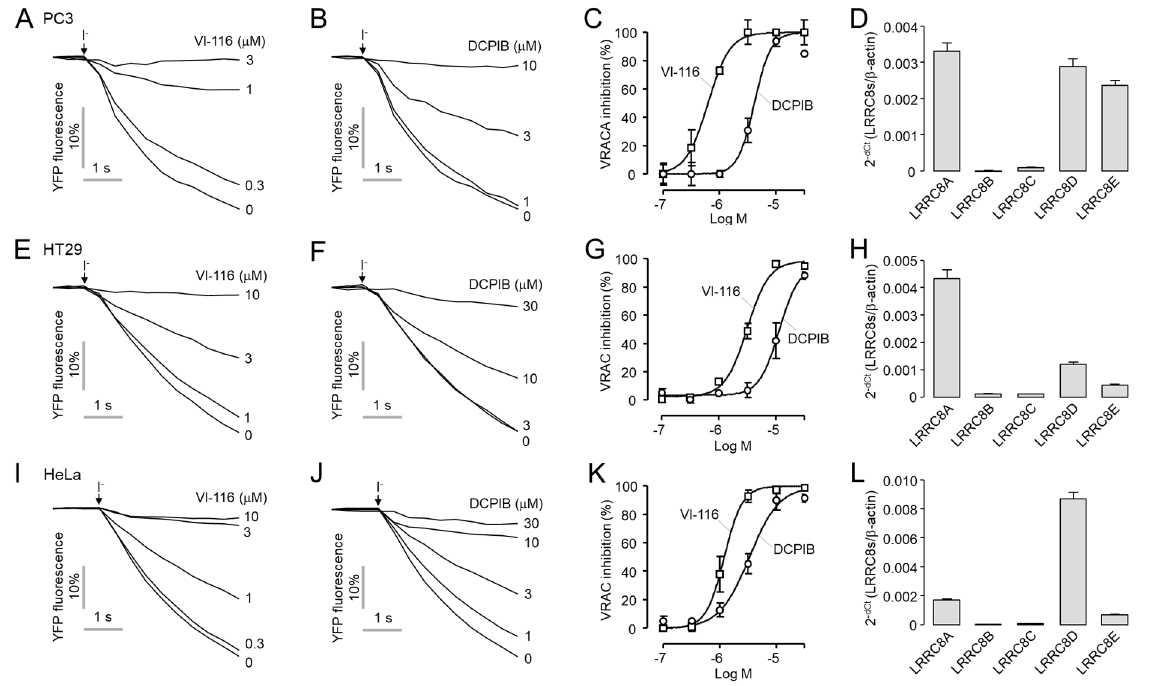
Figure 7. Effects of VI-116 and DCPIB on VRAC activity in PC3, HT29 and HeLa cells. ( A , B ) Repre- sentative YFP fluorescence traces for the inhibitory effects of VI-116 and DCPIB in PC3 cells. VRAC was activated by application of hypertonic solution for 5 min. ( C ) Summary of dose-response (mean ± S.E., n = 4). ( D ) LRRC8A − E mRNA expression levels in PC3 cells. ( E , F ) Inhibitory effects of VI-116 and DCPIB in HT29 cells. VRAC was activated by application of hypertonic solution for 5 min. ( G ) Summary of dose-response (mean ± S.E., n = 4). ( H ) LRRC8A − E mRNA expression levels in HT29 cells. ( I , J ) Inhibitory effects of VI-116 and DCPIB in HeLa cells. VRAC was activated by application of hypertonic solution for 5 min. ( K ) Summary of dose-response (mean ± S.E., n = 4). ( L ) LRRC8A − E mRNA expression levels in HeLa cells. mRNA expression levels of LRRC8A − E were determined by qRT − PCR and normalized to β− actin (mean ± S.E., n = 4).